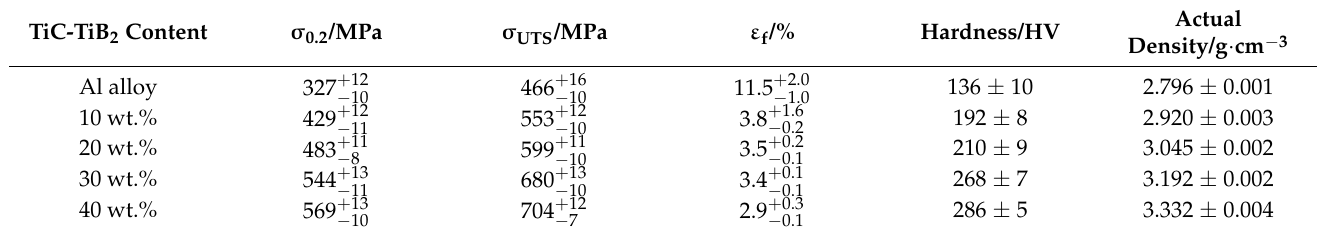
Figure 6. The room-temperature tensile engineering stress-strain curves of the Al-4.7Cu-0.32Mg- 0.44Si alloy and in situ (TiC-TiB 2 )/Al-4.7Cu-0.32Mg-0.44Si composites. Table 2. The room-temperature tensile properties, micro-hardness and actual density of the